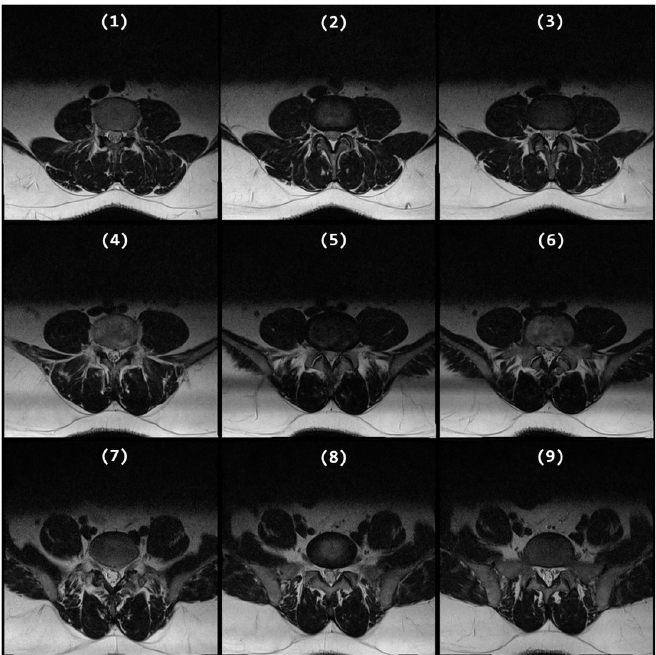
Fig 3. An example of nine traverse images of a lumbar spine. Image 2, 5, and 8 are from the planes that cut closest to the half-height of L3/L4, L4/L5, and L5/S1 IVD, respectively.